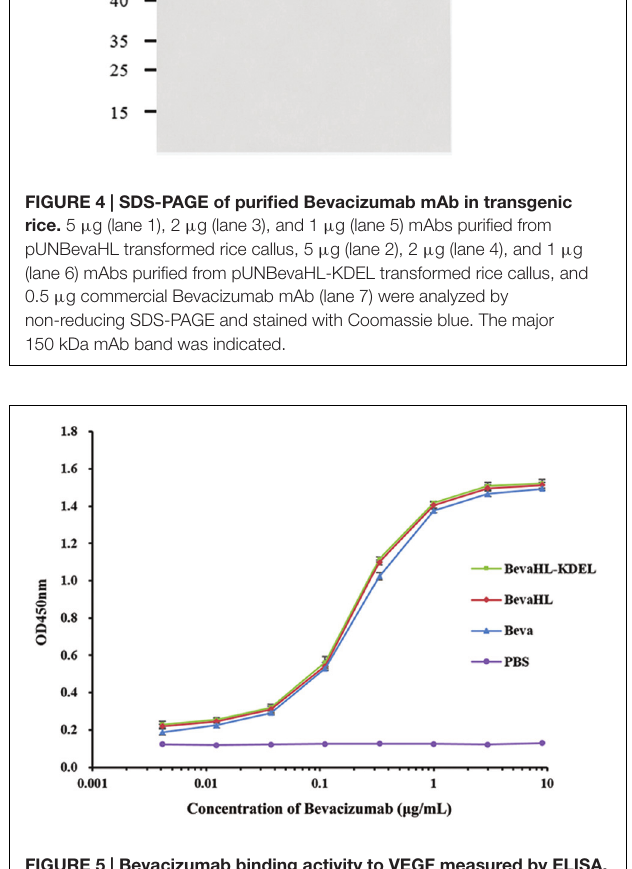
FIGURE 5 | Bevacizumab binding activity to VEGF measured by ELISA. Purified Bevacizumab mAbs from transgenic rice callus with the pBevaHL-KDEL construct (green square) and the pBevaHL construct (red diamond), a commercial Bevacizumab (blue triangle, positive control), and 1 × PBS buffer without Bevacizumab (purple dot, negative control) were analyzed by ELISA for binding activities to hVEGF. Each measurement was performed in triplicates.